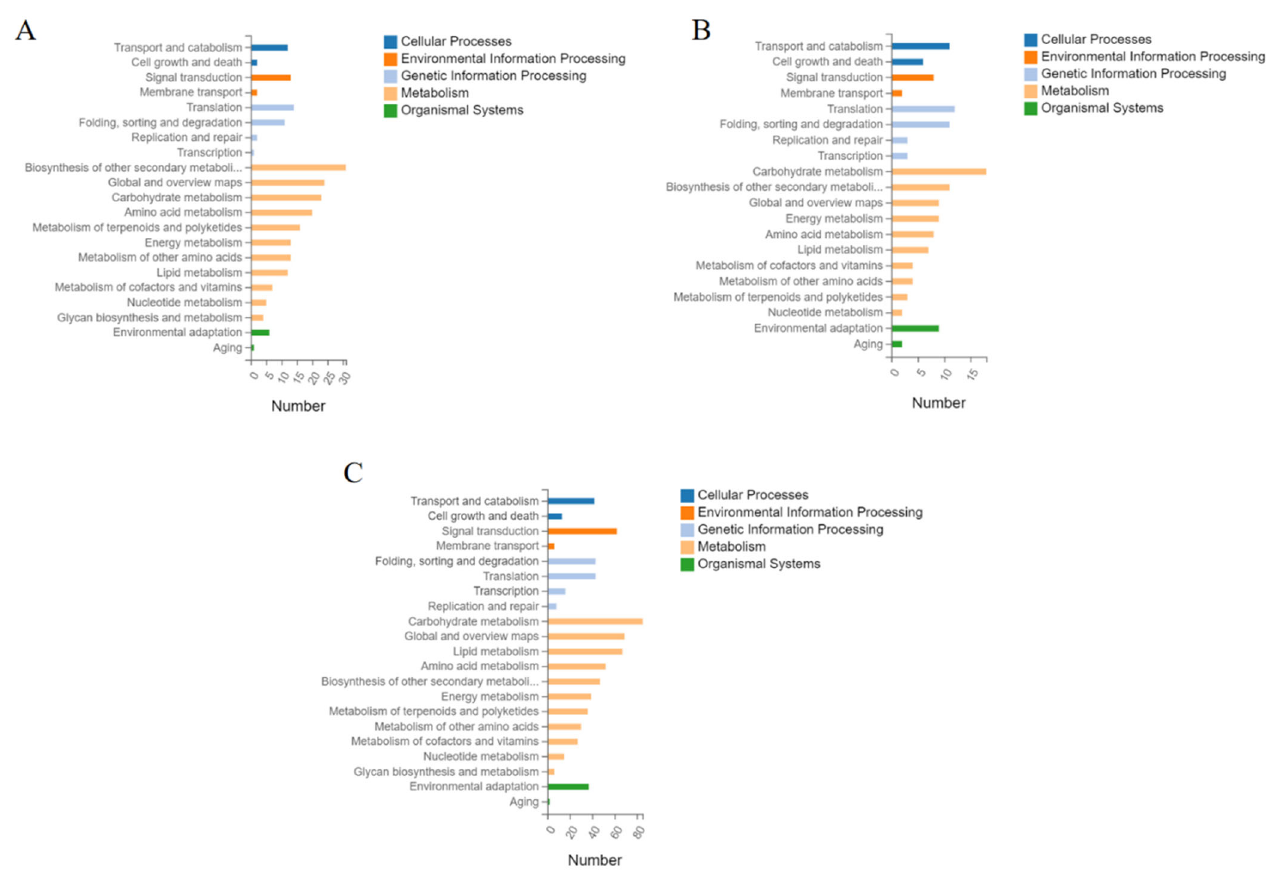
Figure 5. KEGG pathway annotation classification of differentially expressed genes. ( A ) represents the E_SR ‐ vs. ‐ E_CI pathway annotation classification. ( B ) represents the M_SR ‐ vs. ‐ M_CI KEGG pathway annotation classification. ( C ) represents the L_SR ‐ vs. ‐ L_CI KEGG pathway annotation classification. The X ‐ axis represents annotation to a certain KEGG number of genes in the pathway category, and the Y ‐ axis is the KEGG pathway category.